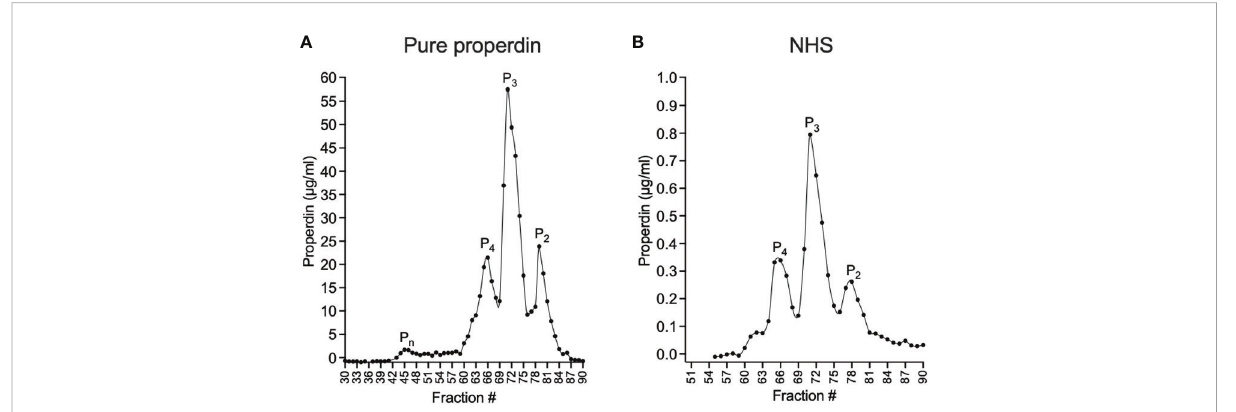
FIGURE 3 Separation of properdin forms in puri fi ed properdin and NHS by size exclusion chromatography and quanti fi cation of properdin in the fractions by sandwich ELISA. Properdin from a pure, unfractionated properdin preparation (A) or in NHS (B) was separated into tetramers (P 4 ), trimers (P 3 ), dimers (P 2 ) and non-physiological aggregates (P n ) by size exclusion chromatography and the concentration of properdin in the collected fractions (diluted 1:3200 (A) and 1:100 (B) ) was determined by sandwich ELISA as described in “ Materials and Methods ” (section 2.5 and 2.6) and graphed.